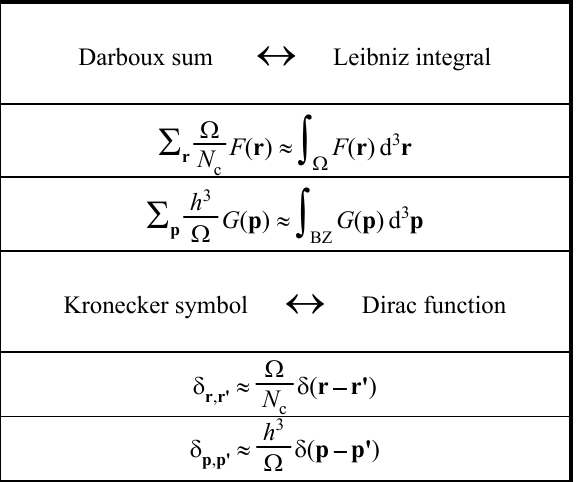
Table 1 . Discrete vs continuum